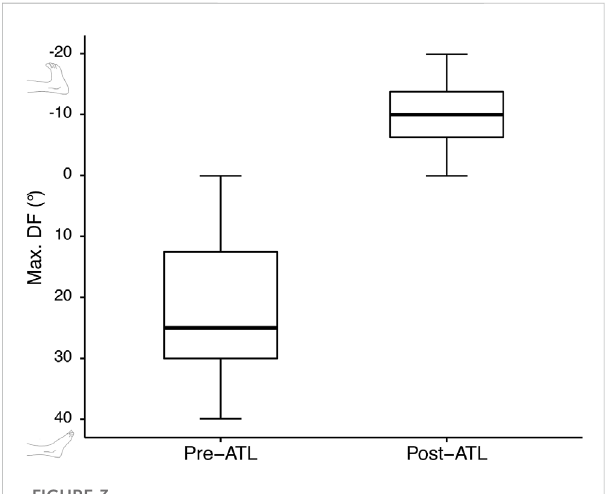
FIGURE 3 The maximal dorsi fl exionpre- and post-ATL, measured passively under general anesthesia.